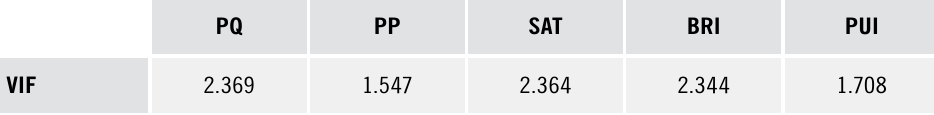
Table 2. Full collinearity test